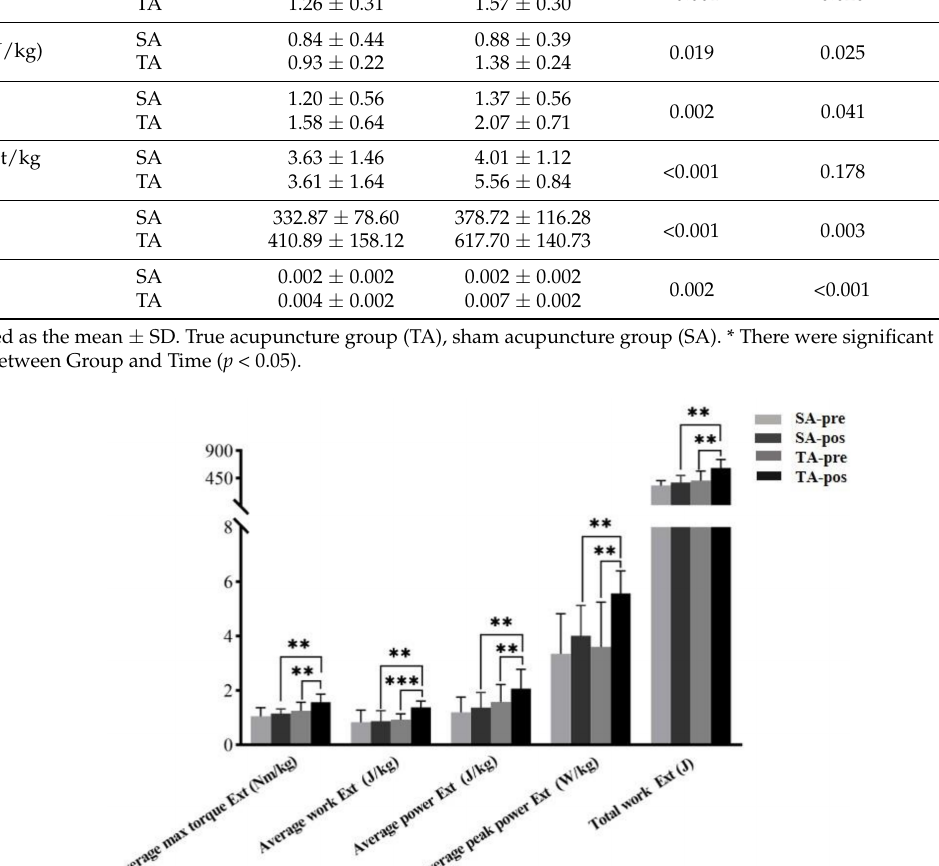
p Values Main Effects Main Effects Interaction ( Time ) ( Group ) ( Time × Group )